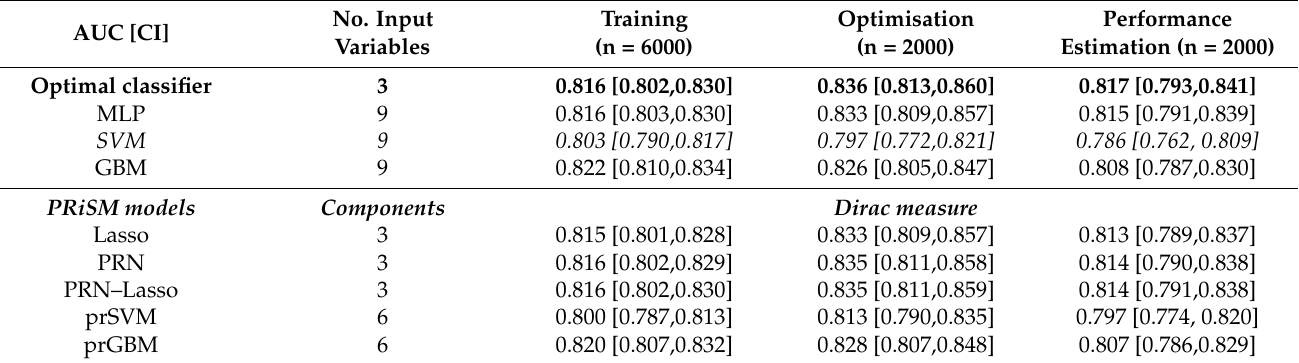
Table 3. Classification performance for the logical AND function measured by the AUC [CI].